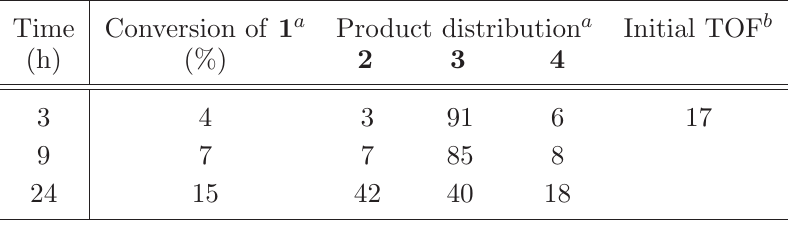
Table 2 Conversion, product distribution and specific activity values in the oxidation of α - methylstyrene with NaOCl solution using complex I encapsulated in